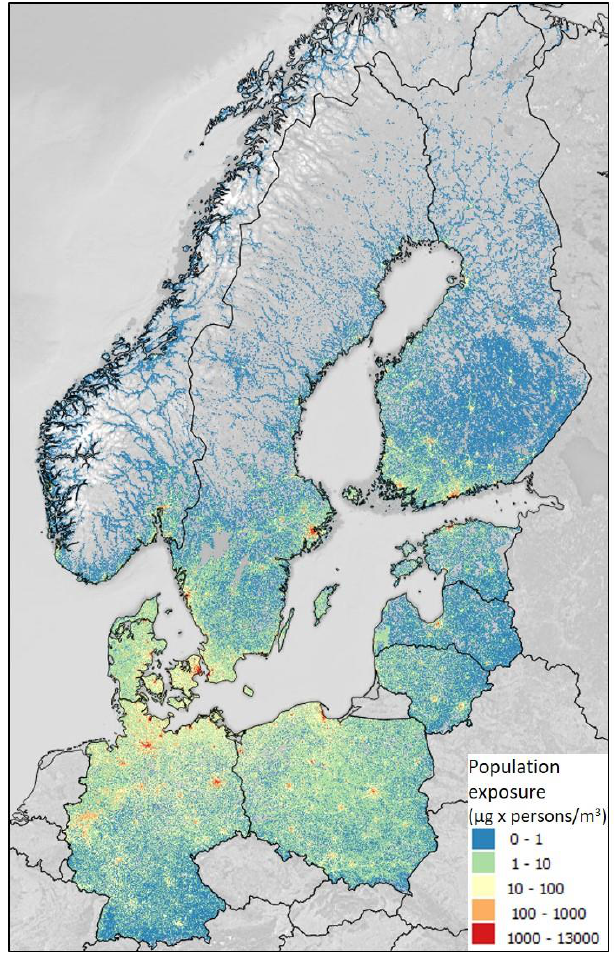
Figure 2. Estimated contribution of shipping emissions in the Baltic Sea to population exposure of PM 2.5 in 2016 (after the SECA regulations of marine fuel sulfur) in each square of 0.1 o × 0.1 o (about 10 × 10 km). The unit is µg/m 3 PM 2.5 × number of persons.